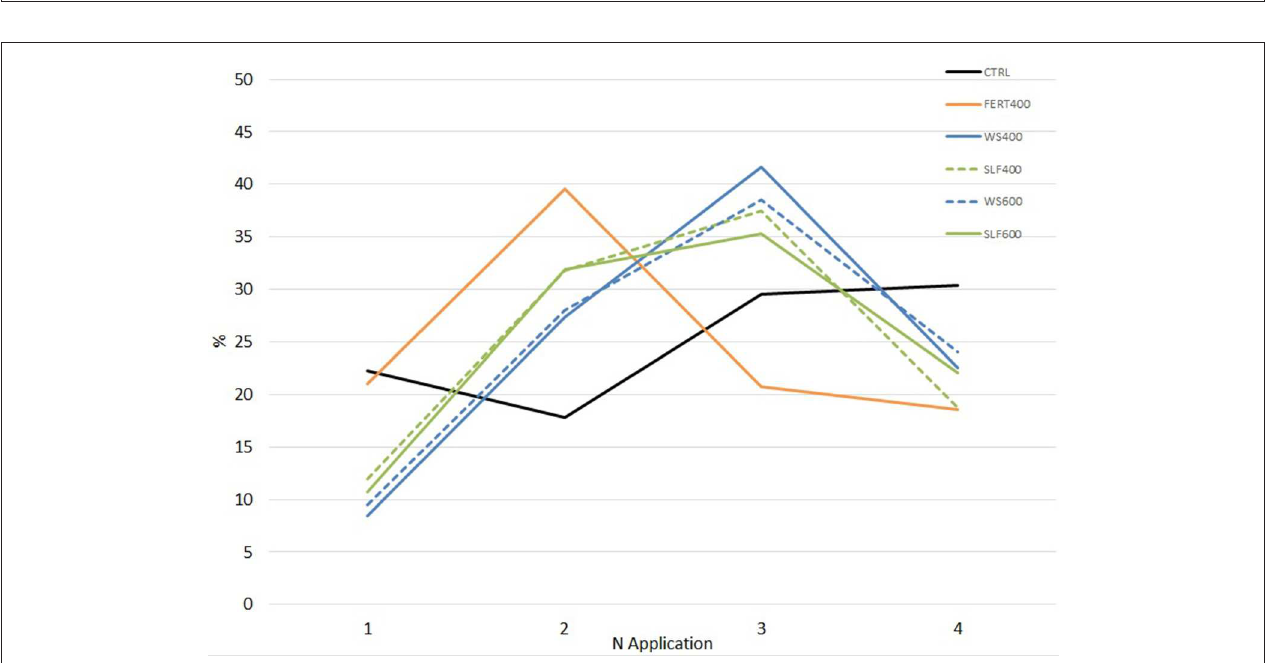
FIGURE 4 | Mean emissions of N 2 O in the week following each of four annual applications of N as whole slurry (WS), separated liquid fraction (SLF) and mineral fertilizer (FERT), expressed as a percent of the cumulative emissions in the interval between application and harvest. Average over 5 years 2008–2012. Dashed line treatments received similar rates of